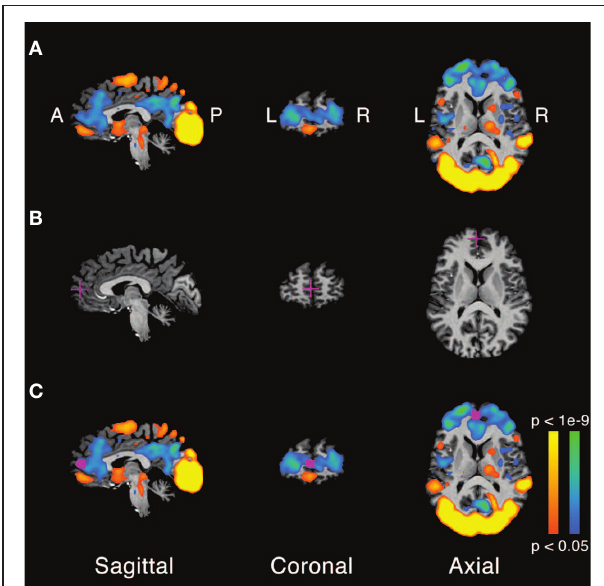
FIGURE 1 | Extrinsic and intrinsic system regions of interest (ROIs). (A) Brain areas activated by the movie clips, for a typical example participant. Orange/yellow, activity evoked by movie clips > uniform gray screen. Blue/green, movie clips < uniform gray screen. A, anterior. P, posterior. R, right and L, left. (B) Anatomical location of the medial prefrontal cortex (mPFC) ROI in this example participant. Cross-hairs, voxel corresponding to the center of the ROI. (C) Anatomically and functionally defined ROI. Orange/yellow and blue/green, activation copied from panel A. Magenta, voxels exhibiting statistically significant activity (panel A) within a cube (12mm on each side) surrounding the center voxel (panel B).